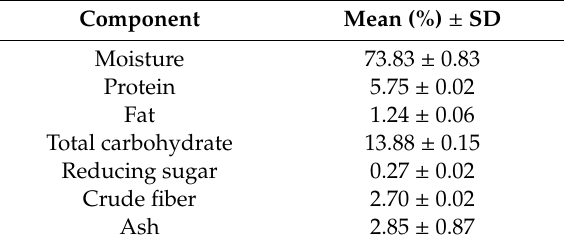
Table 1. Chemical analysis of potato Solanum toberosum var.